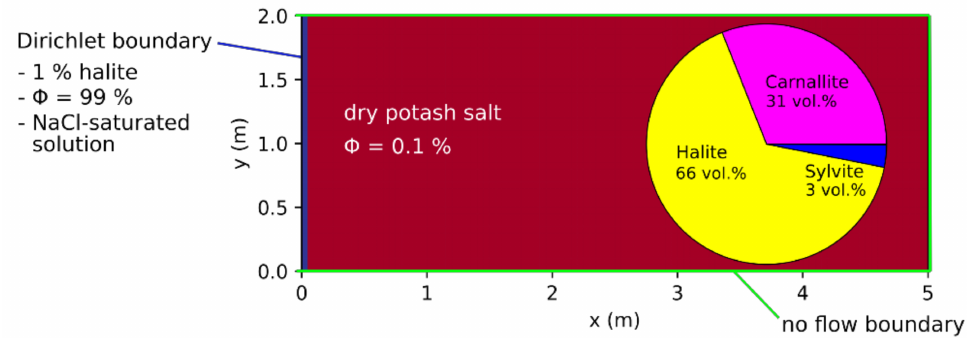
Figure 5. Initial and boundary conditions: the inflow region is prescribed by a Dirichlet boundary (blue line); all other boundaries are impermeable (green lines); the models are initialized as dry with homogeneous potash salt (red, mineralogical composition shown) and halite inclusions according to Figure 6 (modified from Steding et al. [6]).